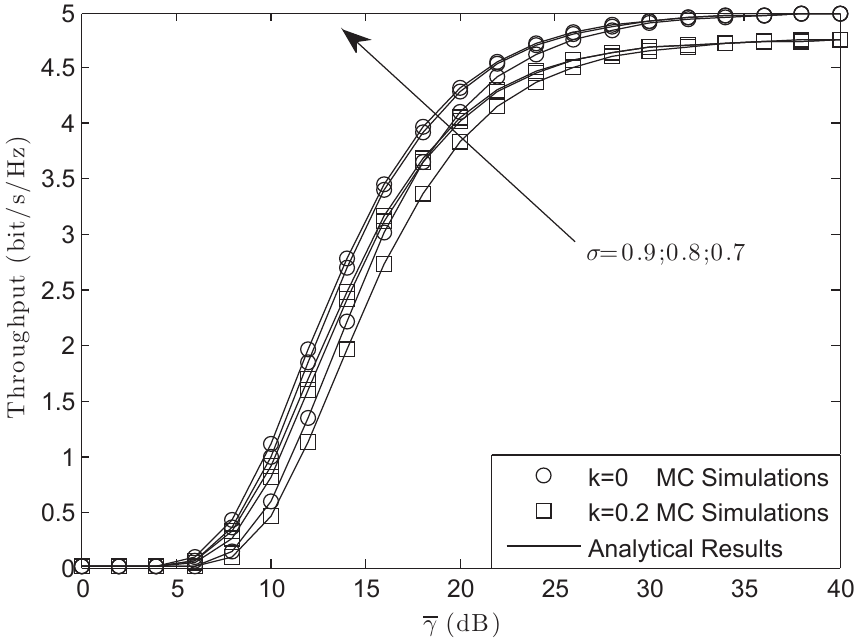
Figure 8. Throughput of the system versus different γ with M = 3, L = 10 and γ 0 = 3 dB: